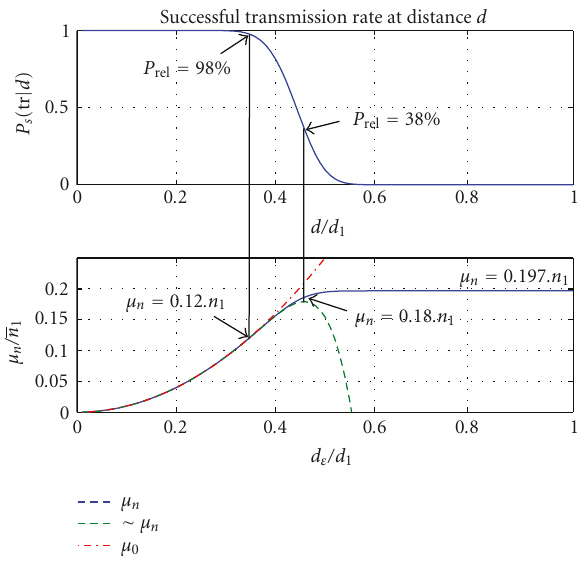
Figure 5: Upper frame: successful transmission probability as a function of the link distance. Lower frame: mean node degree as a function of the system range determined by the power detection level d ε = ε − 1 /α d · d 1 . The exact expression numerically estimated (blue, plain), the approximation according to (43) (green, dashed), and the ideal switched link expression (red, dash dotted) are pro- vided. The optimal mean node degree (0 . 197) can be achieved at the price of having some unreliable radio links. The suboptimal an- alytic solution from (43) is close to the optimal connectivity, having a limit success probability equal to P rel = 38%. On the opposite, reliable links can be obtained at the price of a reduced connectiv- ity. The mean node degree downshifts to 0 . 12. The simulation setup corresponds to a BPSK ( k = 1), a free-space attenuation slope coef- ficient ( α = 2), and 1000-bit length